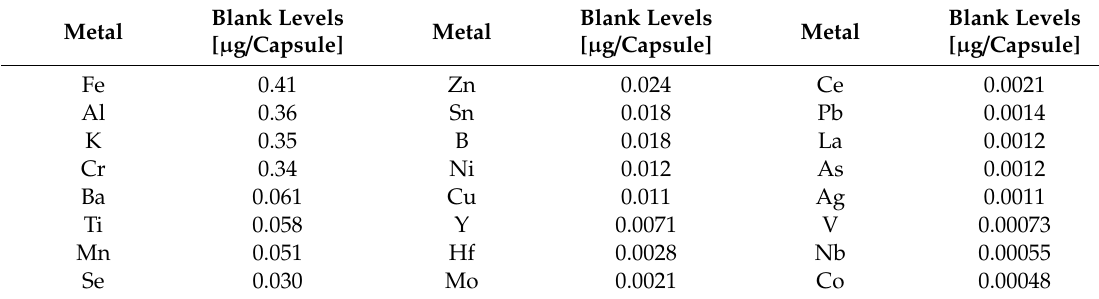
Table 3. Blank levels of the cellulosic capsule of the DIS sampler (median of ten units, data from Wisconsin State Hygiene Laboratory, Madison, WI,